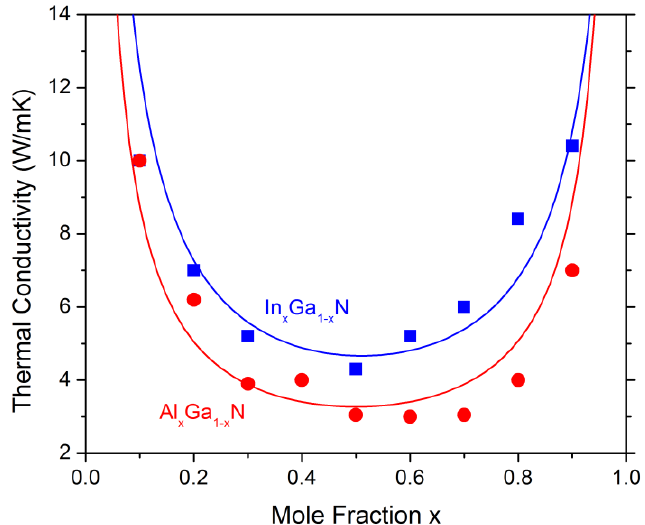
Figure 11. Bulk thermal conductivity as function of alloy parameter x as predicted by a molecular dynamics model [119] (dots) and fitted by an analytical function [117]. Measured values for GaN are near 100 W /